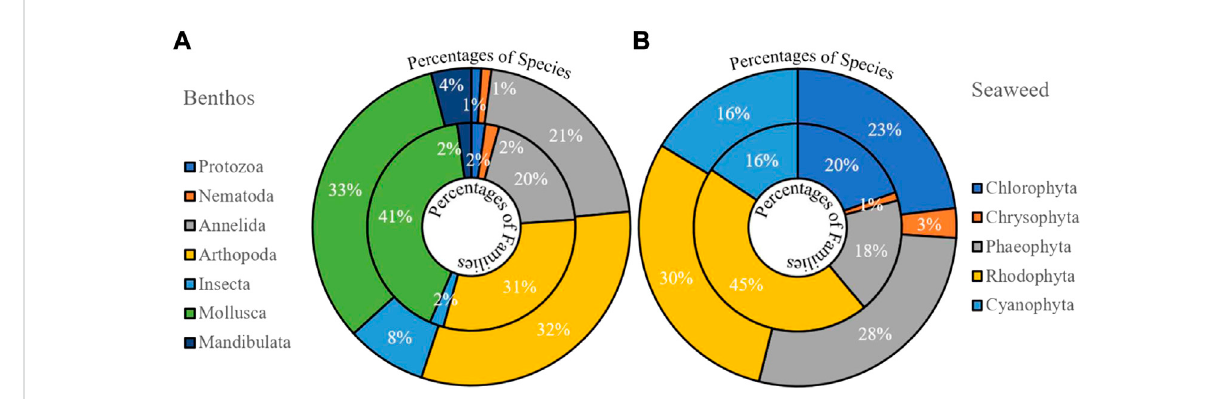
FIGURE 6 Representing available benthos (A) and seaweed (B) distribution in the coastal estuarine areas of